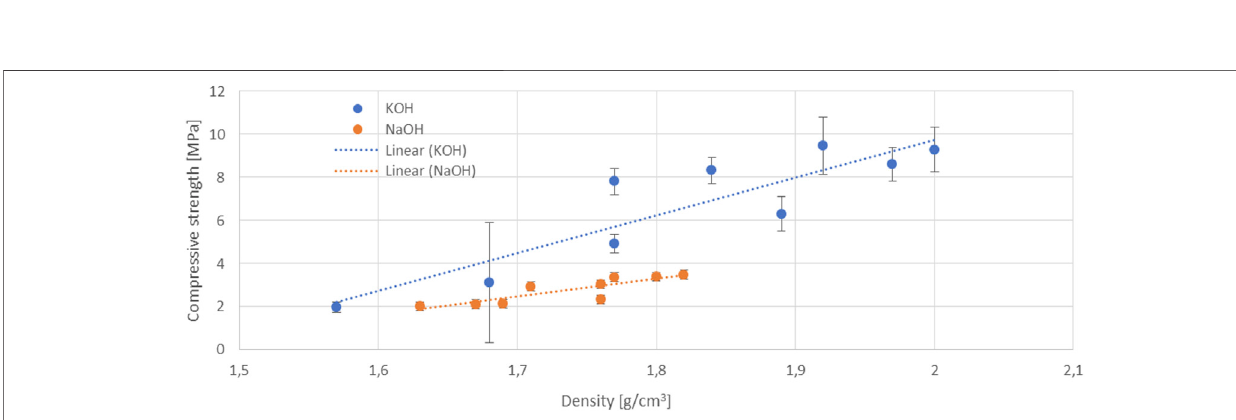
Frontiers in Materials |